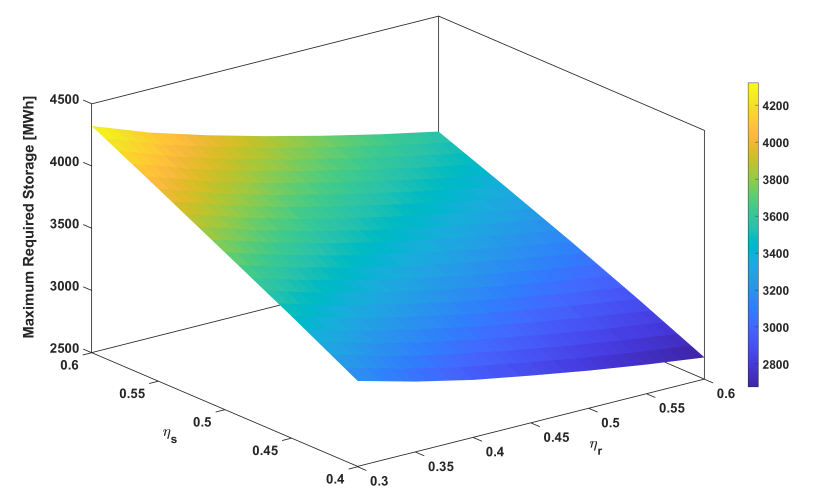
Figure 10. Sensitivity analysis of the maximal required storage to both storing, η s and recovery efficiency, η